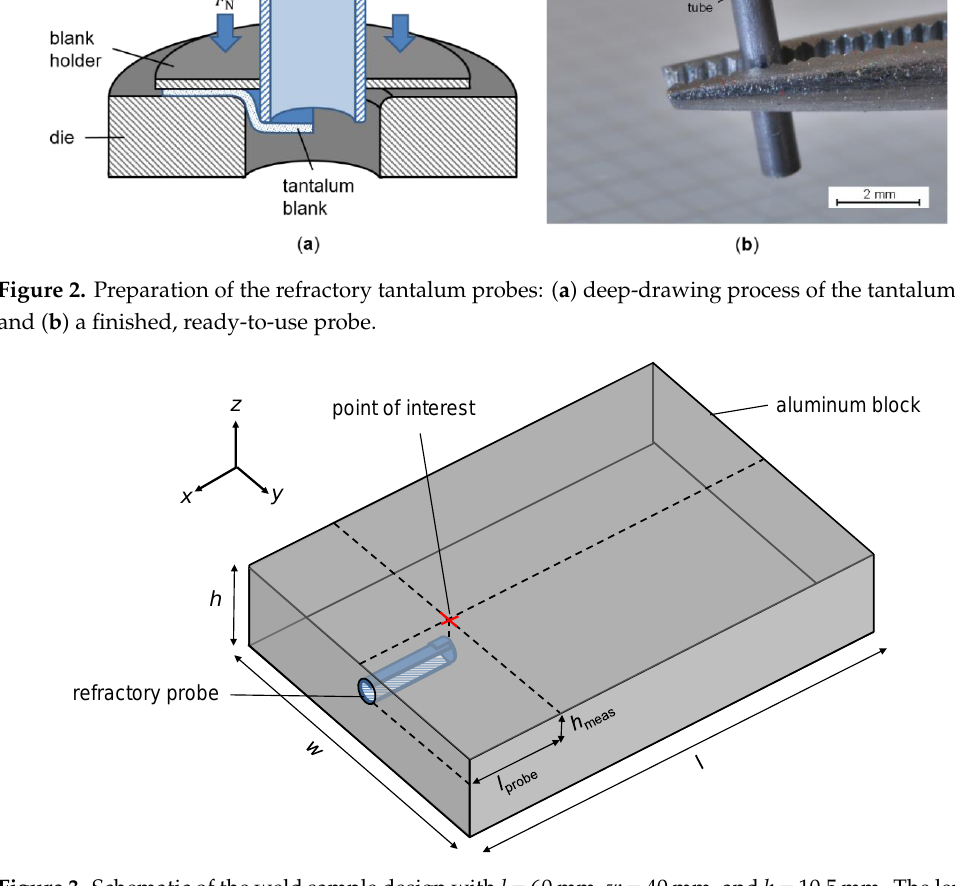
Figure 2. Preparation of the refractory tantalum probes: ( a ) deep-drawing process of the tantalum foil, and ( b ) a finished, ready-to-use probe.